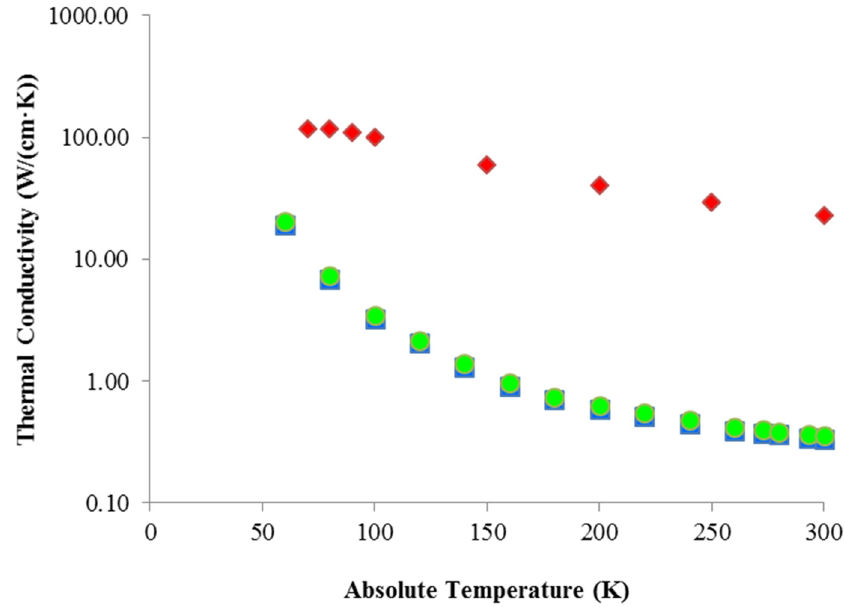
Figure 18. Thermal conductivity as a function of absolute temperature for the uniaxial optical material Al 2 O 3 a (blue [55]) and c (green [56]) axes and for Type II a isotropic diamond (red) [56].